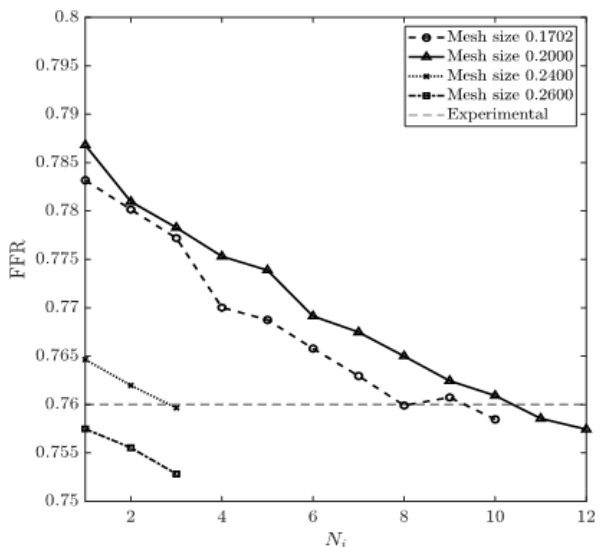
Figure 11. FFR values in each round of iteration for CT209 [19].